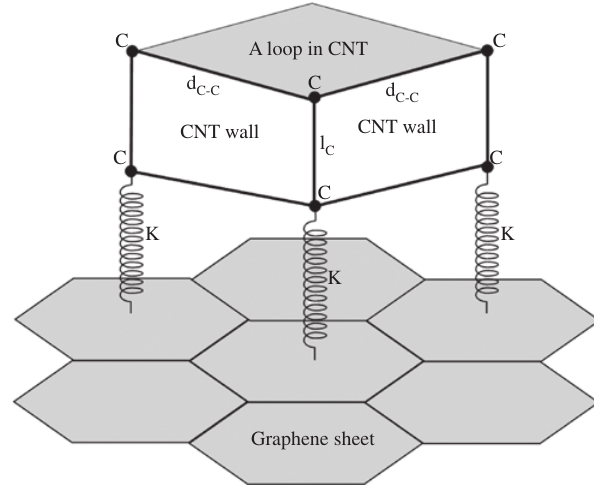
Figure 2: The variations of physical interaction between an adsorbed carbon atom and GS versus the distance between the carbon atom and GS.